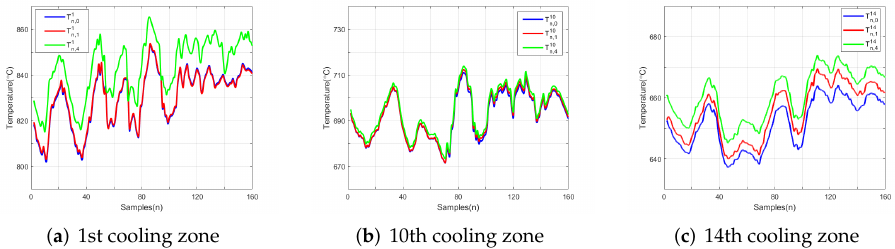
Figure 9. Spatial variation of the strip temperature in the 1st ( a ), the 10th ( b ), and the 14th ( c ) cool- ing